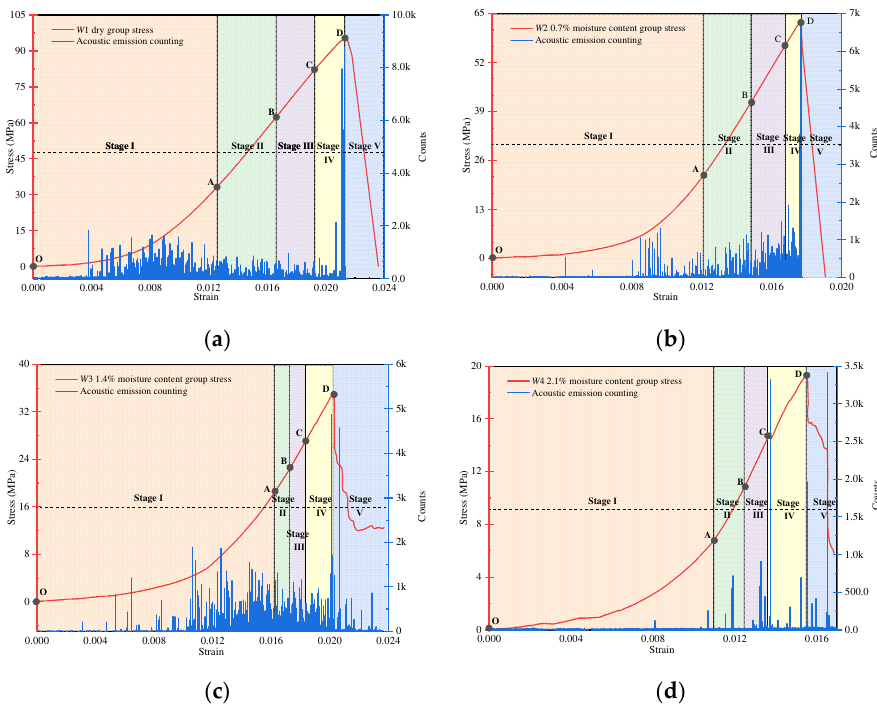
The uniaxial compression process of rock samples can be divided into the fracture compression, elastic stage, fracture stable development, fracture unstable development, of force causes the primary fissure to extend and connect. The CD section is the stage of and post-peak destabilization stages, where the AE generated when damage or defects unstable fracture development (IV), which is the most intense stage of damage before the are enlarged inside the rock samples has certain regularity, and each stage is divided destruction of the rock sample. After point D, in the post-peak destabilization stage (V), the based on the magnitude and frequency of AE counts. The relationship between σ and ε, rock sample still has a certain bearing capacity and fracture expansion, and weak surface the AE counts of typical rock samples in each group and the division of each stage are damage will continue to occur in some relatively intact block structures. shown in Figure 8.